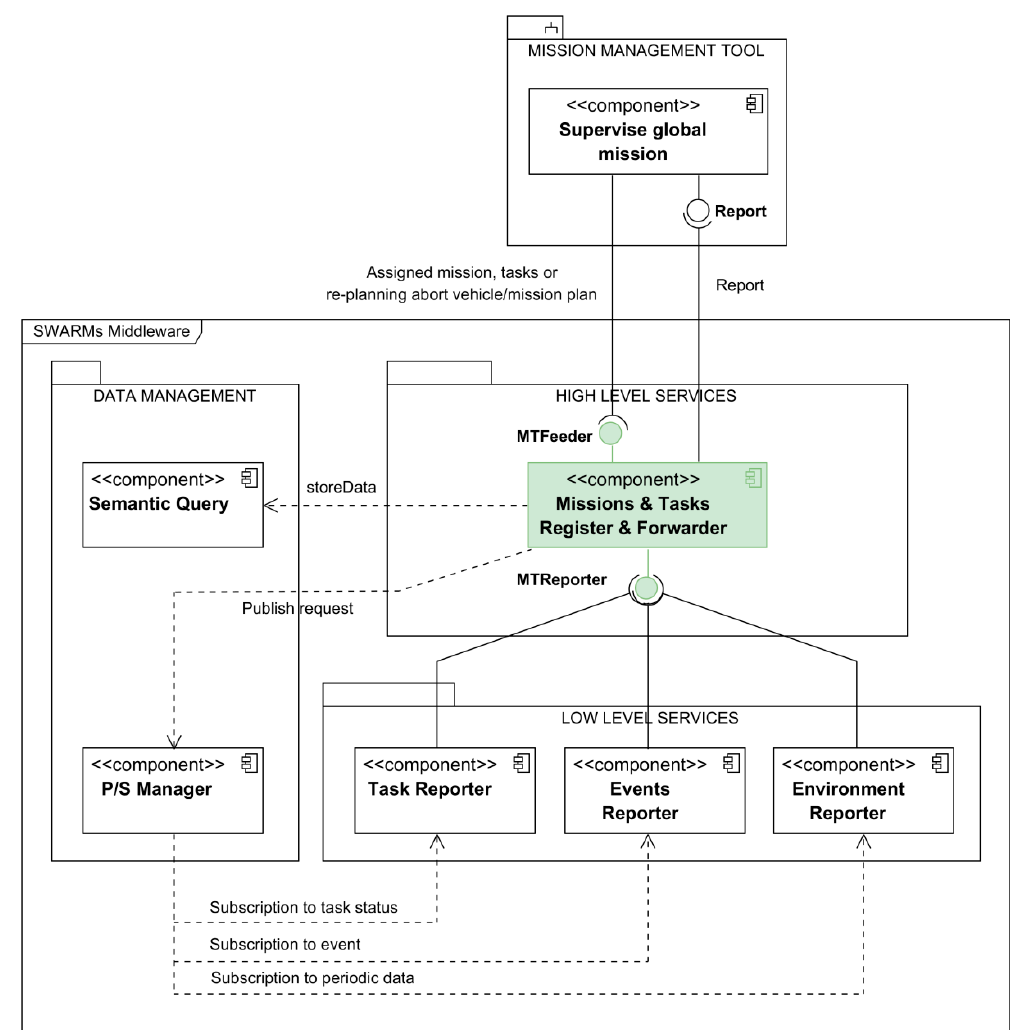
Figure 17. Relations between the mission manager (MTRR) and other SWARMs components.